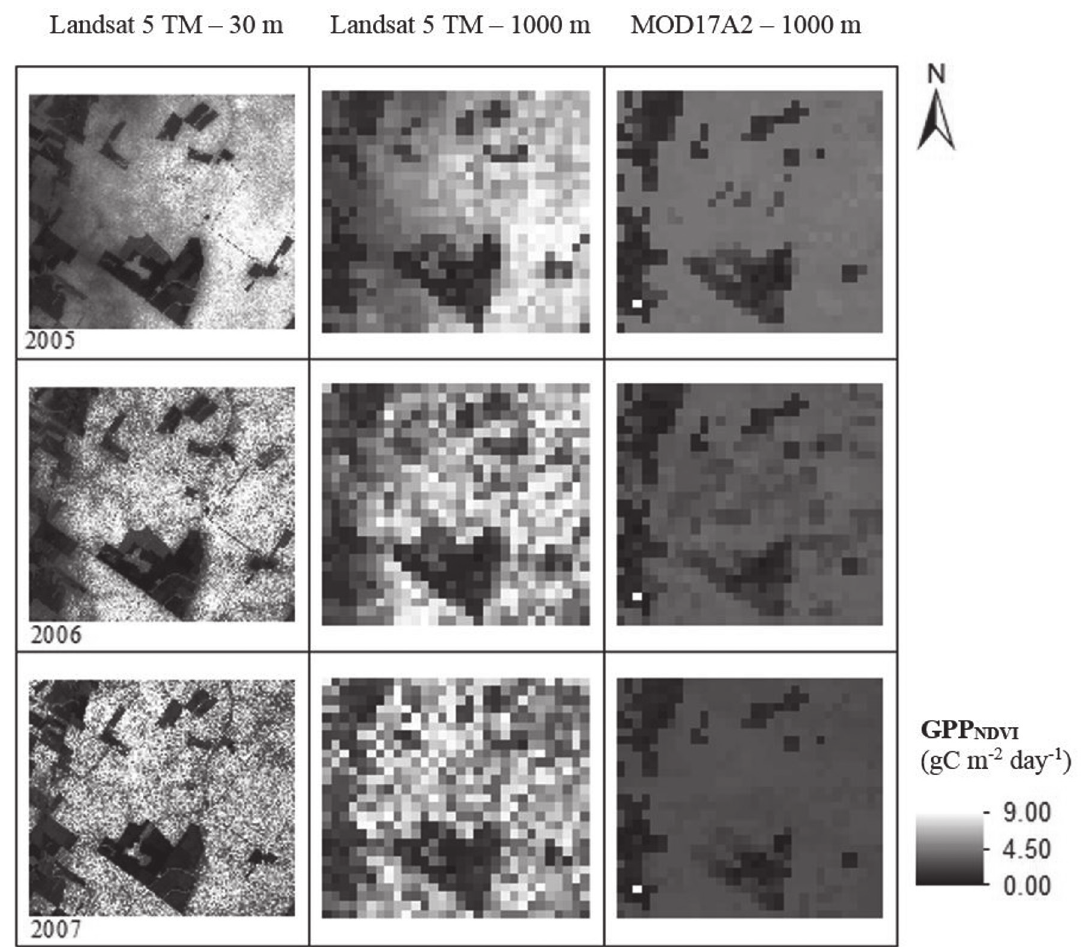
Fig. 9 - Maps of annual average GPP estimated from Vegetation Photosynthesis Model (VPM) using Normalized Difference Vegetation Index (NDVI) from Landsat 5 TM with 30 m and 1000 m of spatial resolution and by MOD17A2 MODIS GPP